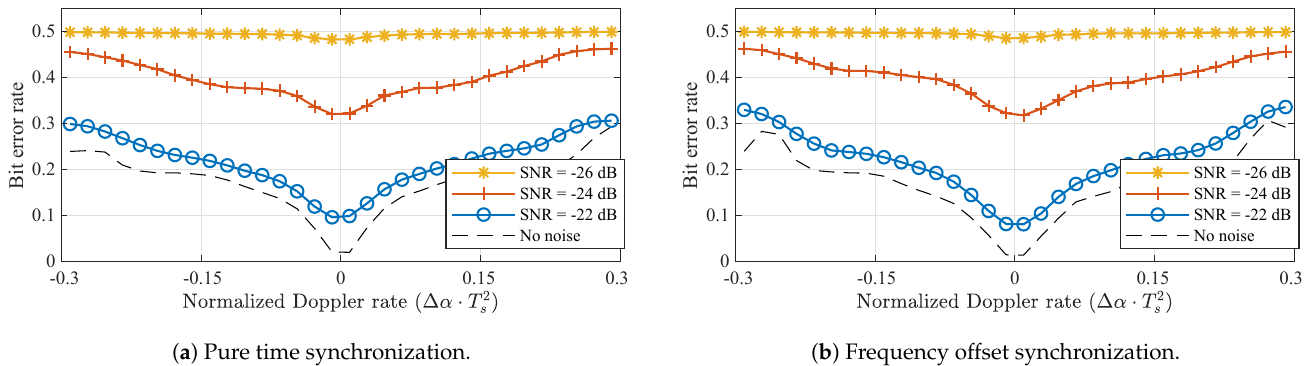
Figure 10. BER performance for different dynamic Doppler shifts, using the different synchronization strategies illustrated in Figure 4 (SF = 12, B =